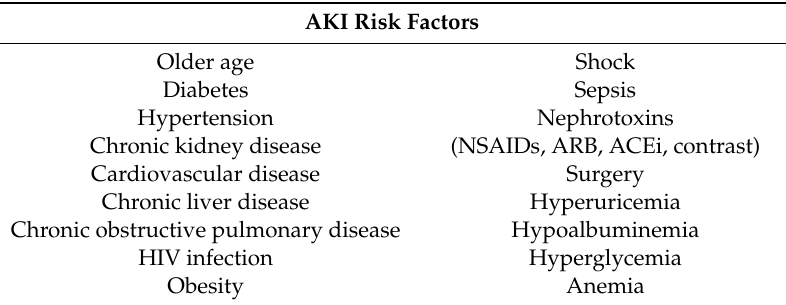
Table 2. Risk factors for acute kidney injury